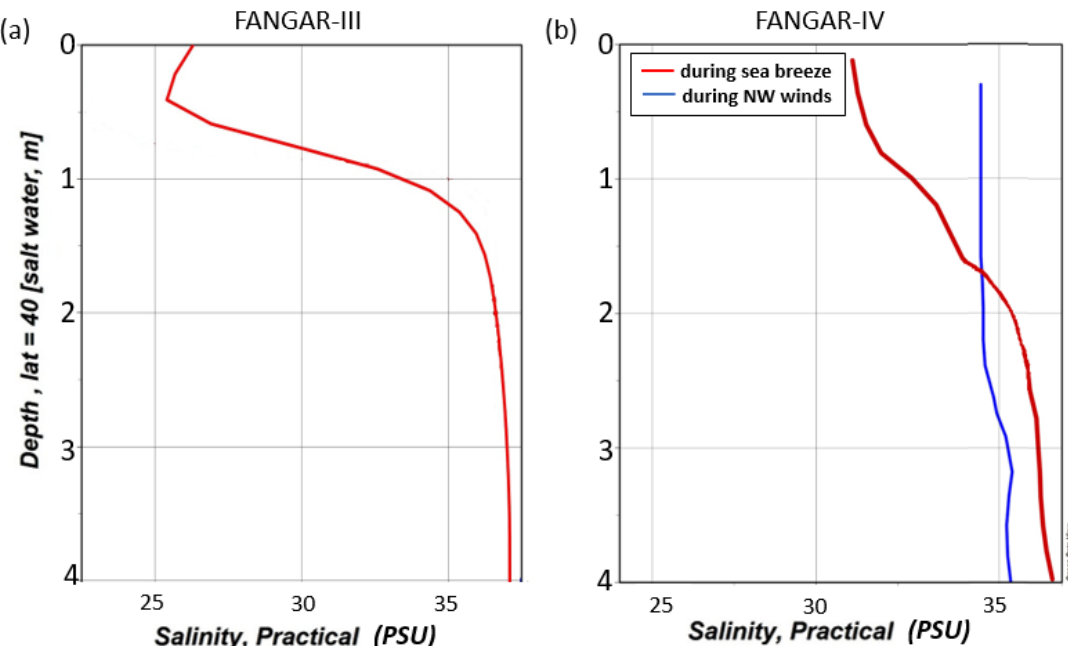
Figure 6. Average salinity profiles from FANGAR-III ( a ) and from FANGAR-IV ( b ) from CTD surveys.